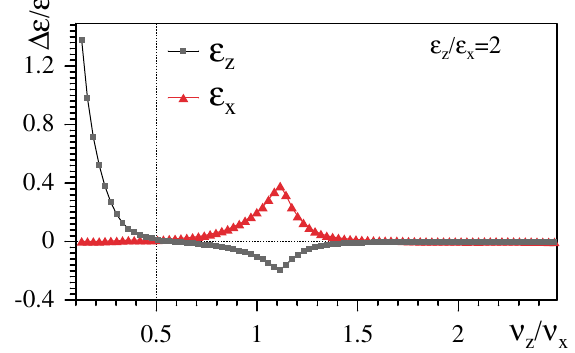
(cid:3) 0 : 5 and =(cid:10) x 0 x